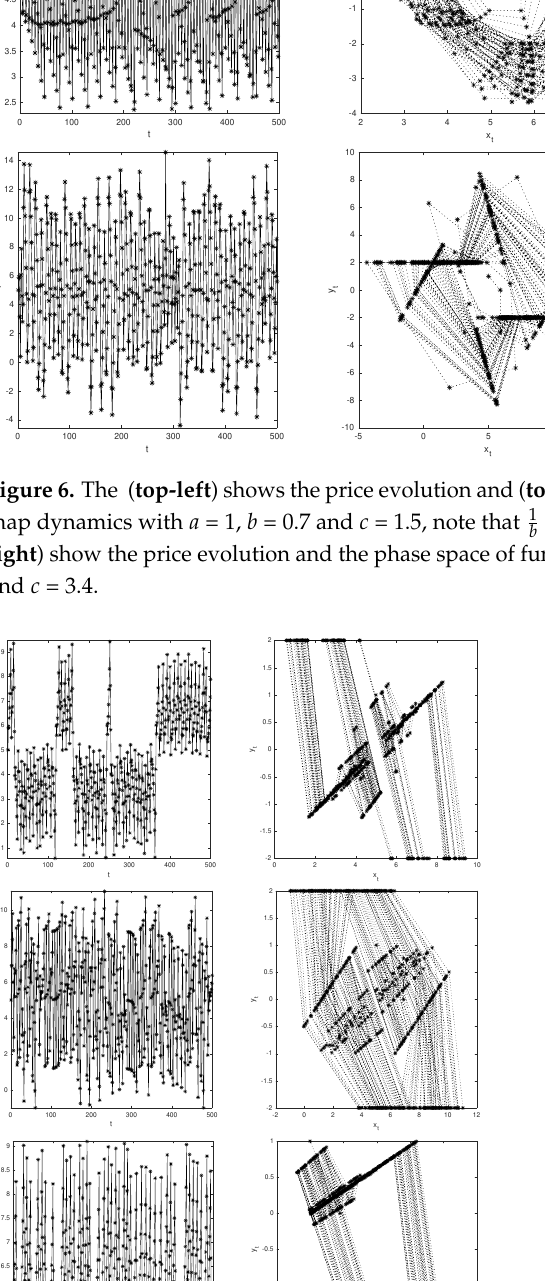
Figure 7. The ( top-left ) shows the price evolution and ( top-right ) the phase space of the fundamental map dynamics with a = 1, b = 0.9 and c = − 0.5; while ( middle-left ) and ( middle-right ) show the price evolution and the phase space of fundamental map dynamics with a = 1, b = 1.9 and c = − 0.4, while in the ( bottom ) it holds a = 1, b = 0.9 and c = −